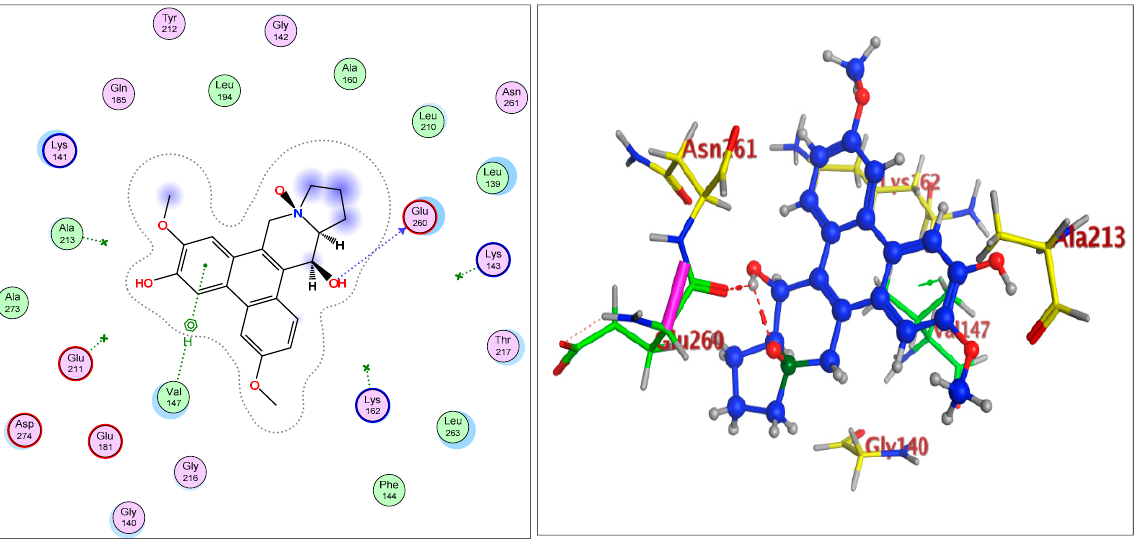
Figure 2. Overlay of compound ( 5 ) bound to the active site of ATP-binding pocket of Aurora-A.